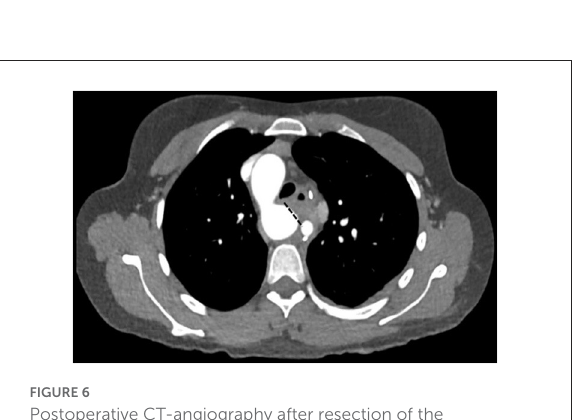
FIGURE6 Postoperative CT-angiography after resection of the diverticulum (dotted line). Just on the right is the distally translocated left subclavian artery. Reproduced with permission from Cardiovasc Med: w10132: doi